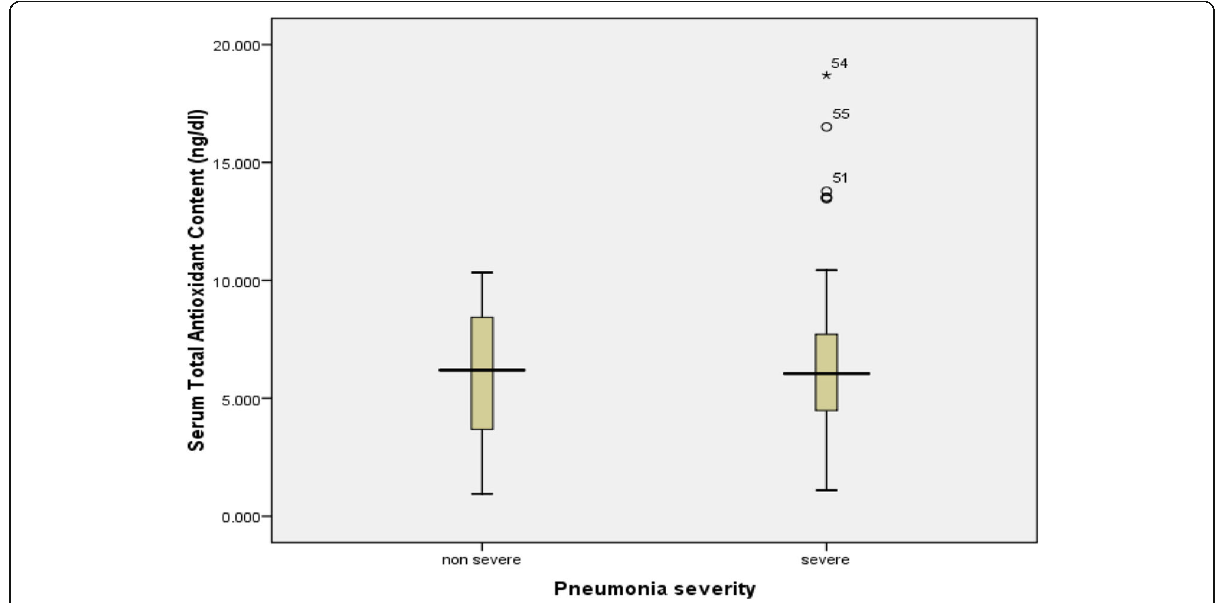
Fig. 2 Boxplot of serum total antioxidant capacity and pneumonia